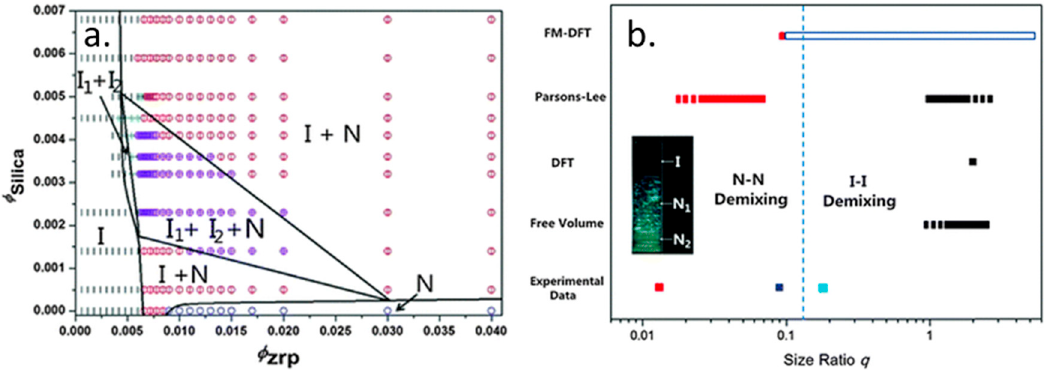
Figure 13. ( a ) Phase diagram as a function of ZrP plate and silica sphere concentrations. ( b ) The distribution of nematic–nematic demixing and isotropic–isotropic demixing found from several different theoretical frameworks as well as experimental data, as a function of size ratio q where q = R particle / R platelet . The dark blue squares give the bar size ratio in experiment and the light blue squares gives the effect size ratio accounting for ion clouds. The red square is the experimental observation of I–N 1 –N 2 demixing at q ~ 0.013. The long empty rectangle box stands for neither I 1 –I 2 nor the N 1 –N 2 demixing, while the solid red rectangle stands for N 1 –N 2 demixing, and the solid black rectangle stands for the I 1 –I 2 demixing. Dashed rectangles indicate that the limit valve has yet to be determined. The vertical dotted line indicates the possible boundary between I 1 –I 2 and N 1 –N 2 demixing. Reproduced with permission from Chen, M.; Li, H.; Chen, Y.; Mejia, A.; Wang, X.; Cheng, Z. Observation of isotropic–isotropic demixing in colloidal platelet-sphere mixtures. Soft Matter 2015, 11, The Royal Society of Chemistry [10] .